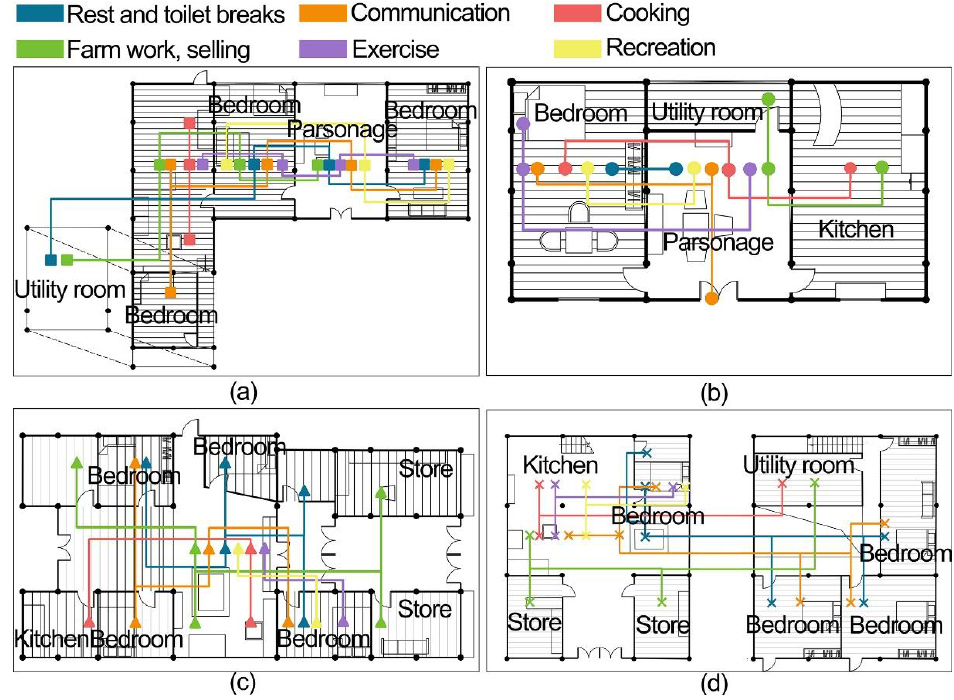
Figure 5. Daily activities of the elderly in the ancient town of Tujia. ( a ) L-shape dwelling, ( b ) Zuozi dwelling, ( c ) front store and back house dwelling, ( d ) lower store and upper house dwelling.